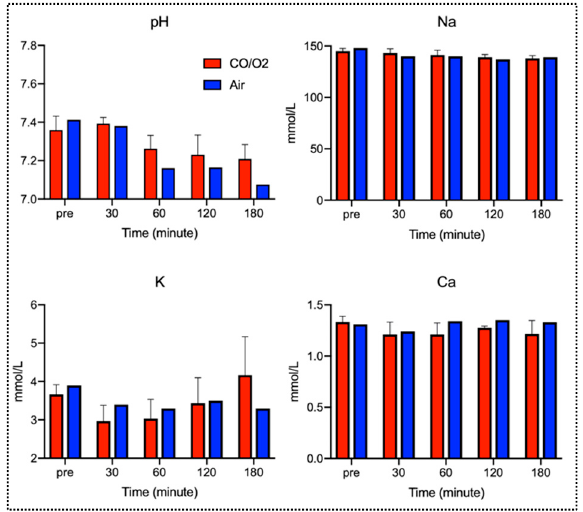
Figure 7. Arterial blood gas analysis for pH, Na, K, and Ca levels in the CO / O 2 and air groups. The red bars show parameters in the CO / O 2 group, and the blue bars show parameters in the air group. Each data of red bars are expressed as the means ± standard deviations.